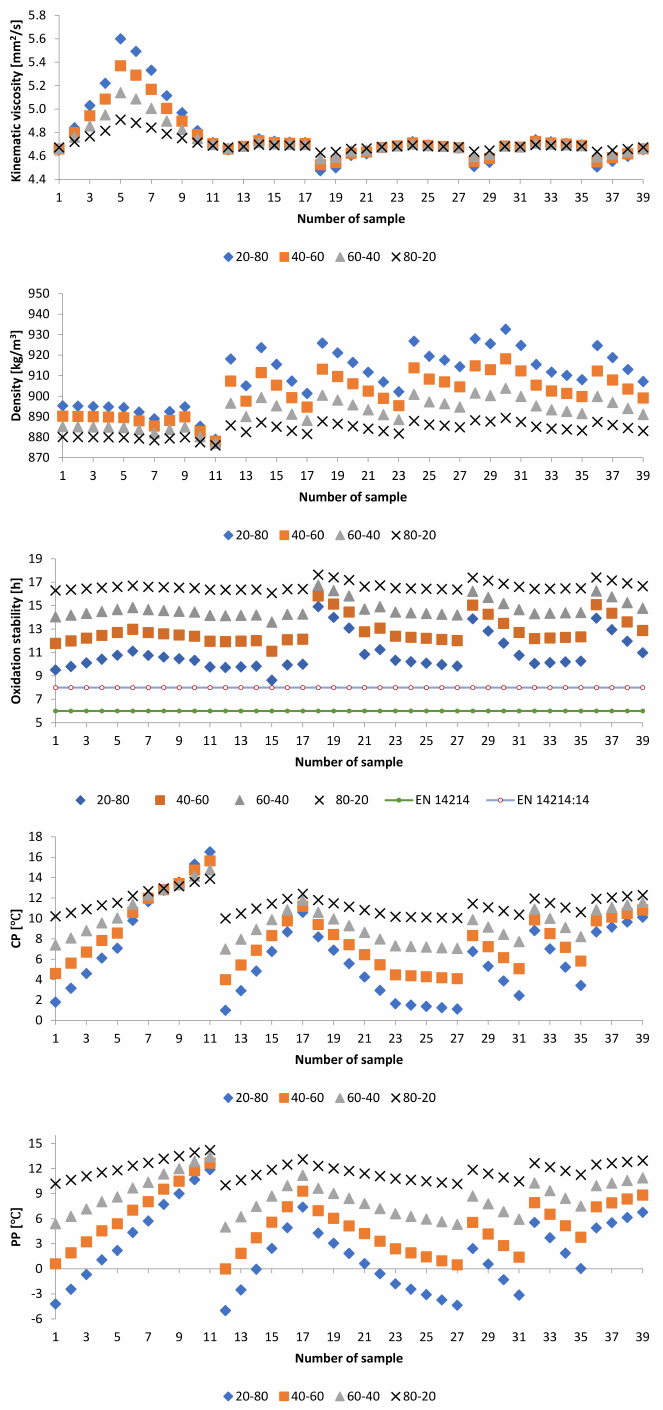
Figure 4. Properties of the mixture (PME-WFME) with various ratios (20:80 means 20% v / v of palm oil biodiesel and 80%